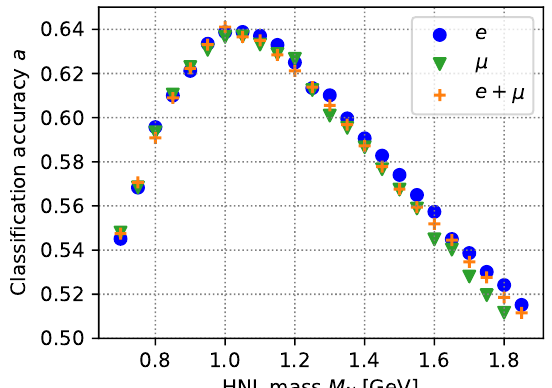
Figure 8. Classi(cid:12)cation accuracy as a function of the mass, for an HNL coupling to e , (cid:22) , or equally to both.